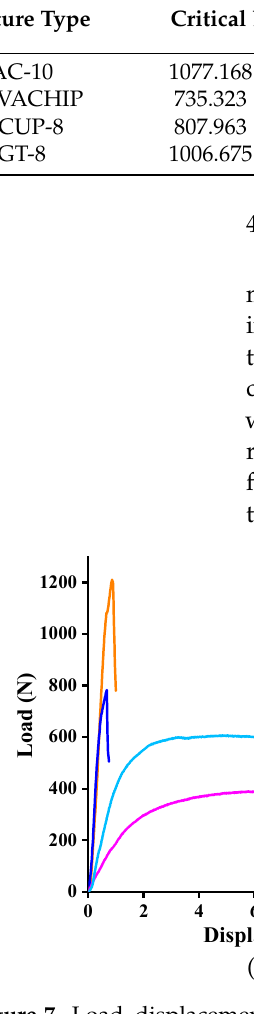
Table 11. Results of low temperature bending test.